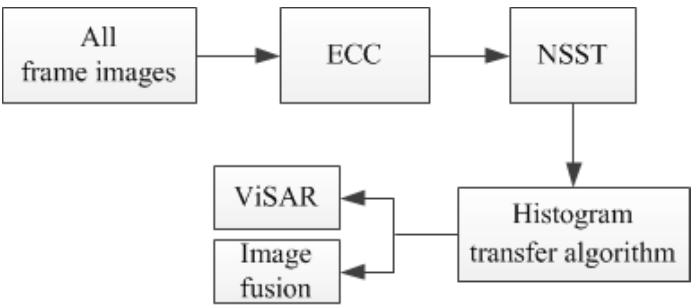
Figure 14. The flowchart of forming ViSAR and Image fusion.